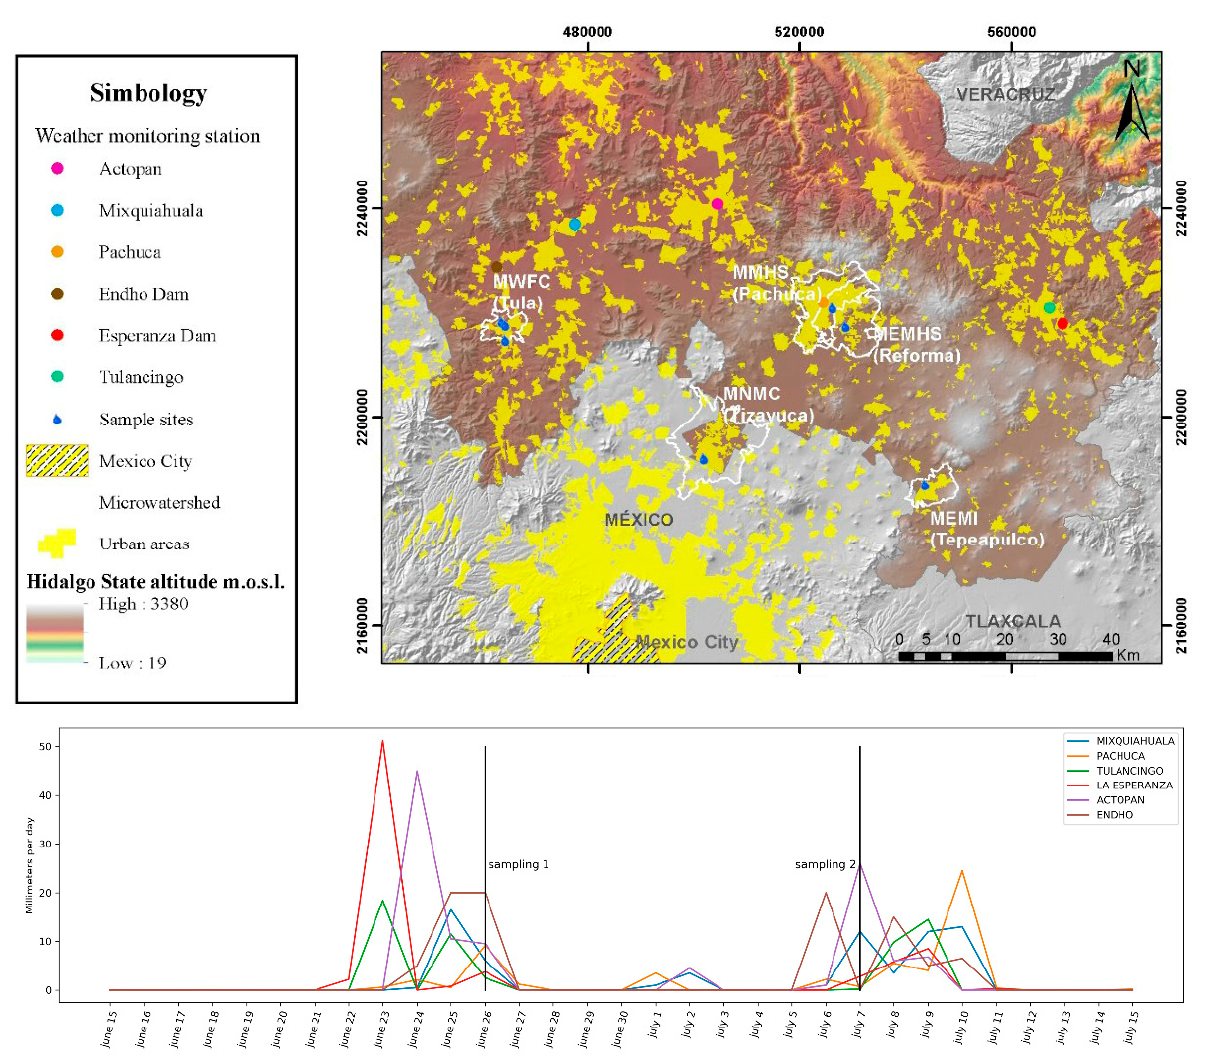
Figure 4. Sampling places and data from weather monitoring stations about precipitation (mm per day).